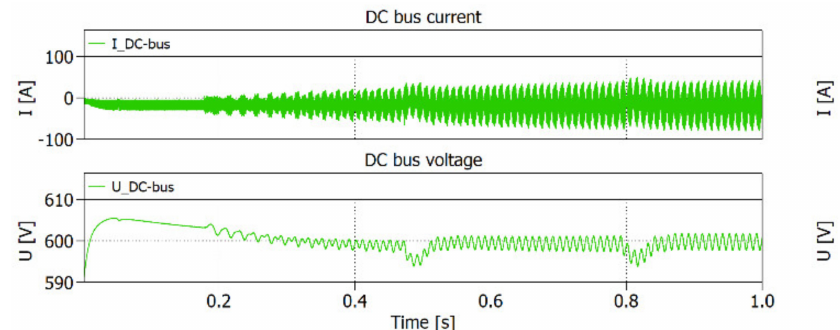
Figure 25. Current and voltage of the DC bus for Scenario 2.